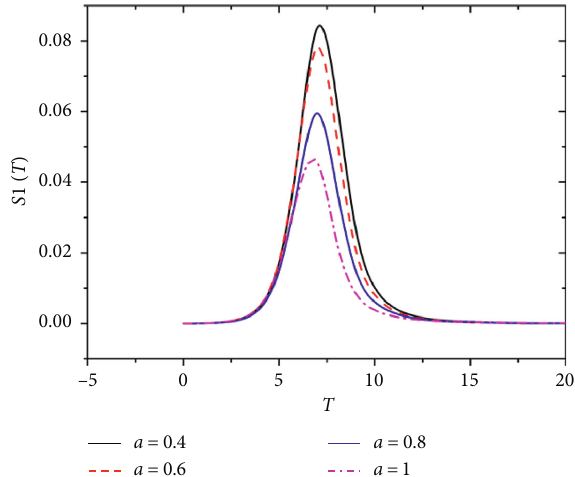
Figure 6: Density of spreader1 over time for different values of α .